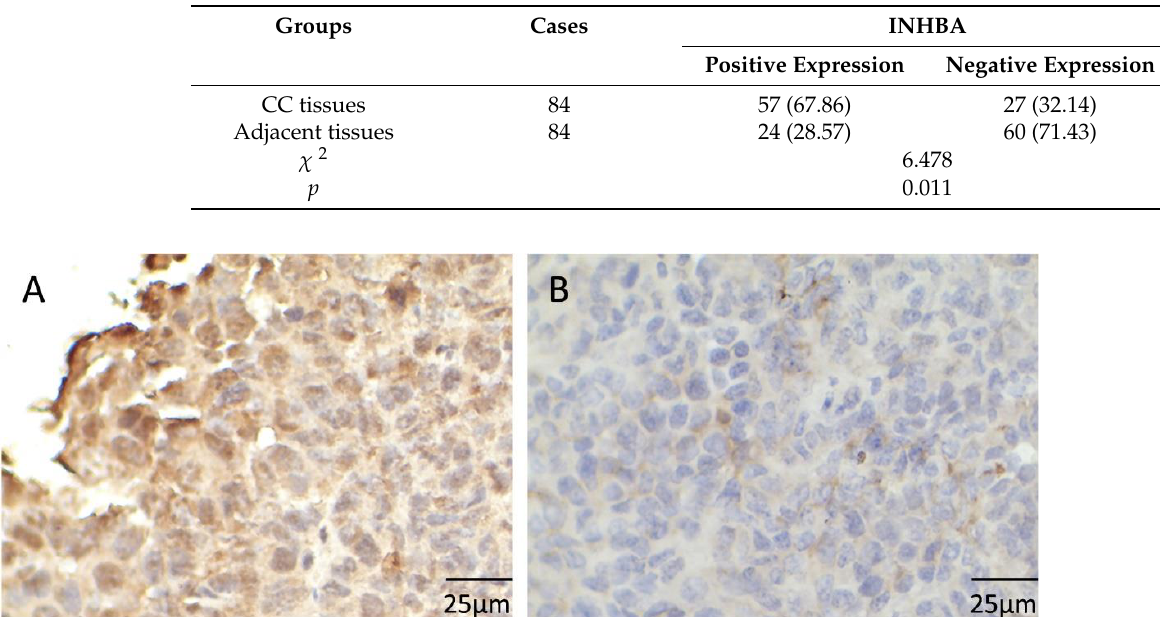
Table 1. Detection of inhibin beta A (INHBA) expression in cervical cancer (CC) tissues by immunohistochemistry (IHC) (cases (%)).